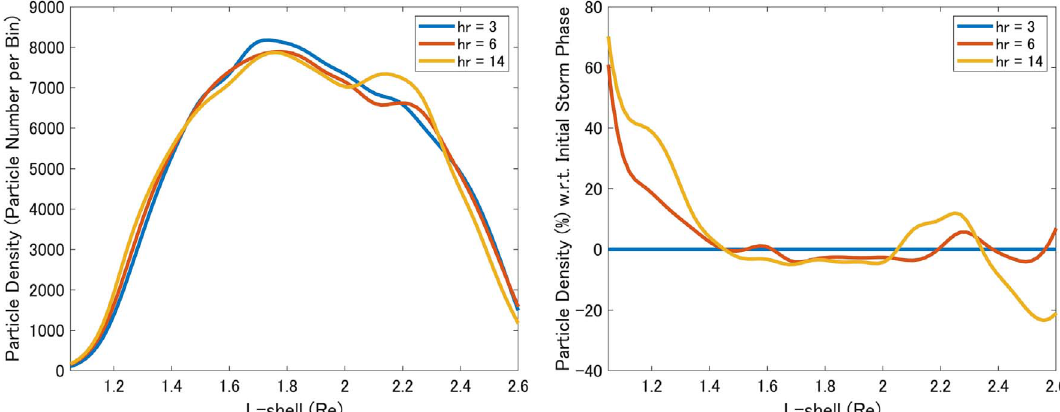
Fig. 4. The left panel visualizes the proton density distribution along the L -shells during the three phases of the geomagnetic storm (blue line: initial phase, red line: main phase and yellow line: recovery phase), while the right panel shows the proton density variations (increase and decrease) with respect to the initial storm phase. The particle density is determined over the same energy as in Figure 3.